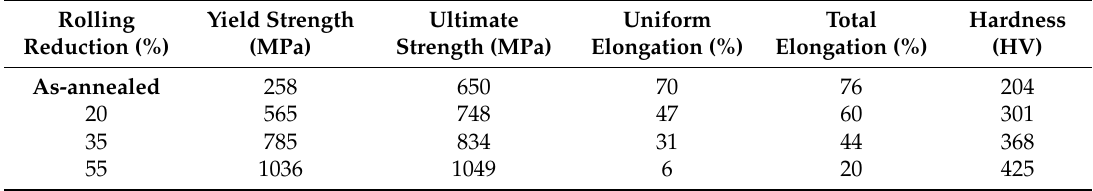
Table 2. Mechanical properties for the specimens with different rolling